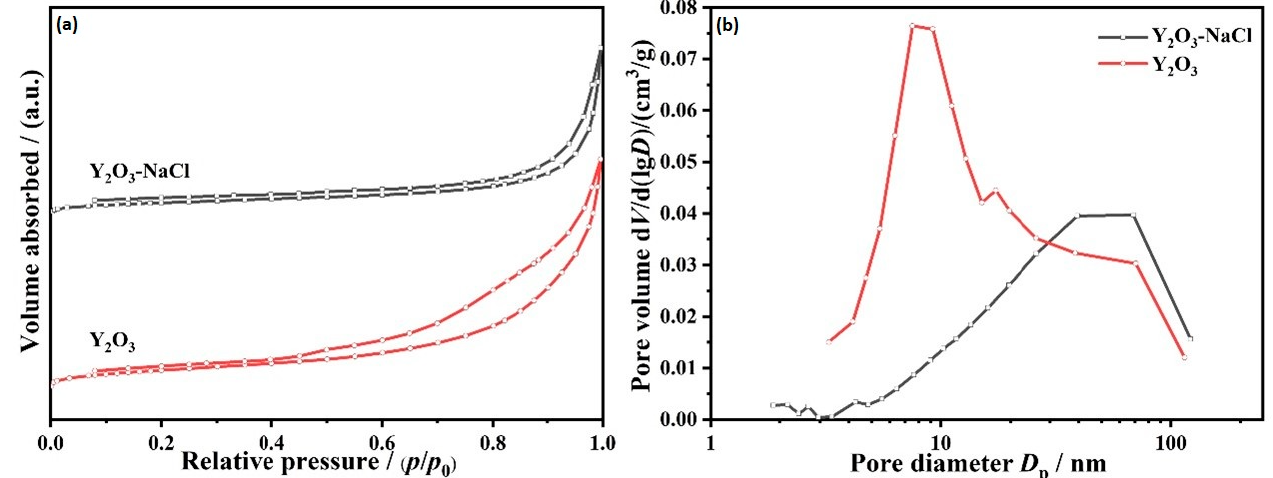
Figure 3. Nitrogen adsorption–desorption isotherms ( a ) and pore size distributions ( b ) of as-prepared Y 2 O 3 -NaCl and Y 2 O 3 supports. Table 1. Metal mass ratios of Pt/Y 2 O 3 ( C Pt / Y ), BET specific surface areas ( S BET ), BJH pore volume ( V p ),